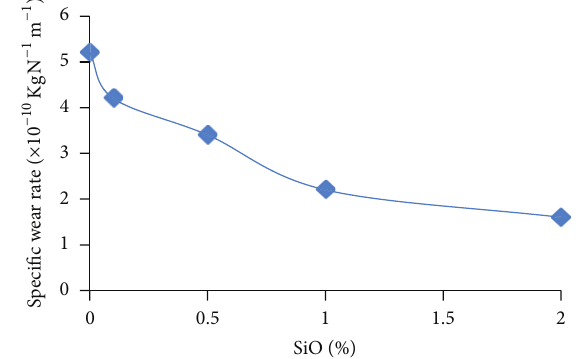
Figure 13: Variation in microhardness of EN-coatings as a function of SiO with surfactant (SLS) in EN bath.